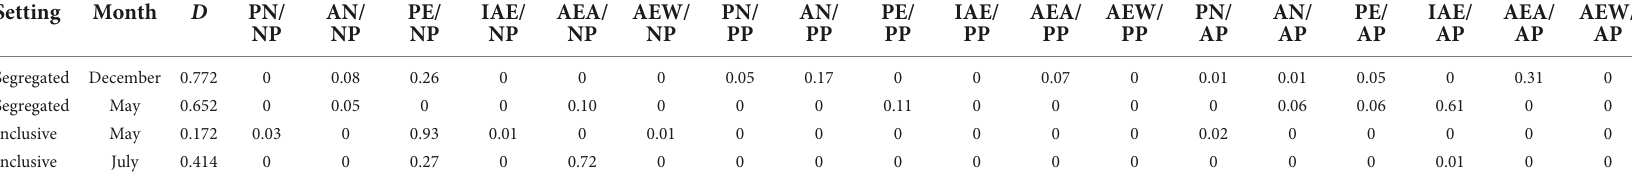
TABLE 1 Frequencies of states, child engagement, and adult participation during free play.